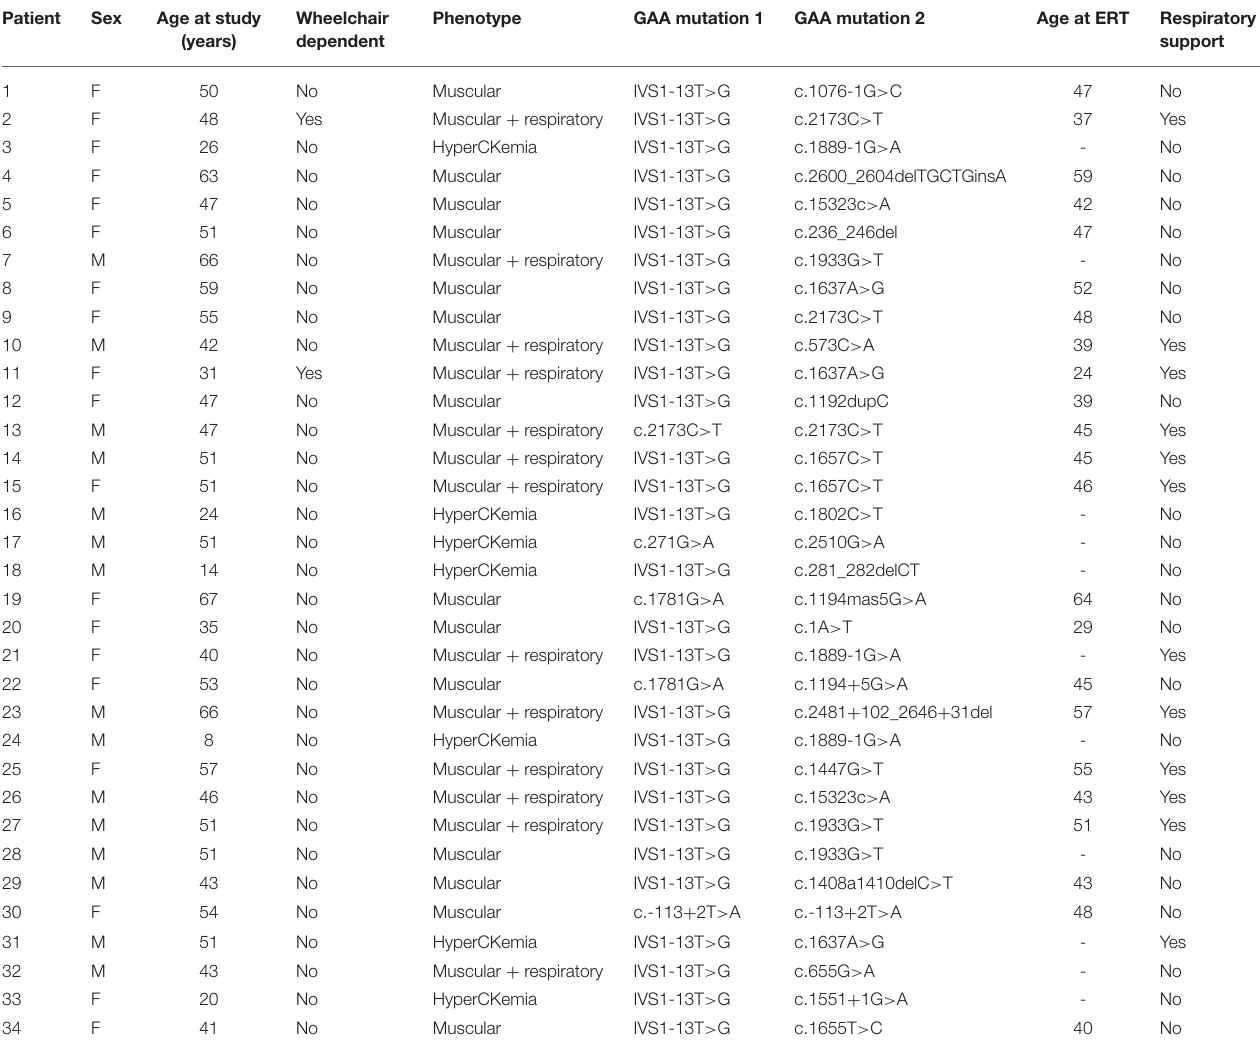
TABLE 1 | Clinical characteristics of the